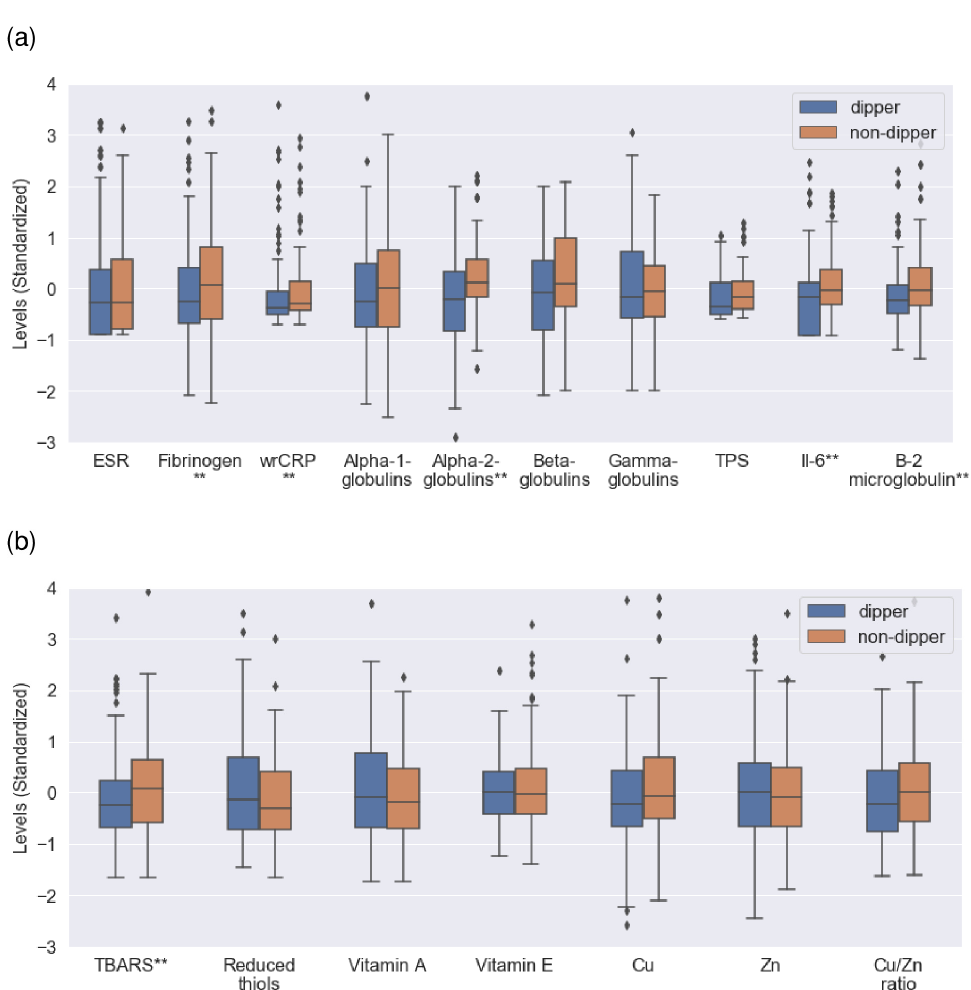
Figure 1. Comparison of inflammatory and redox marker levels between dipper and non-dipper patients. ( a ) Inflammatory markers (dipper and non-dipper groups, from left to right): ESR (mm/h): 8.0 (2.0–14.0), 8.0 (1.5–14.5). Fibrinogen (mg/dL): 284 (249–318), 304 (259–349). wrCRP